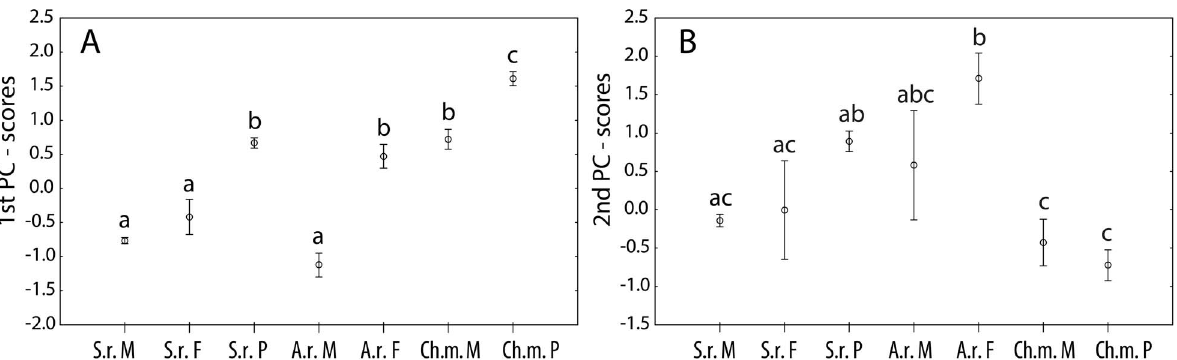
Fig. 3. Multivariate analysis of stoichiometric relations in three species of xylophagous beetles (PCA). ANOVA computed independently for the 1st and 2nd axis scores A – ANOVA for scores of the 1st principal component (F6, 76 5 91.919, p 5 0.0000); B – ANOVA for scores of the 2nd principal component (F6, 76 5 8.8204, p 5 0.00000); vertical bars denote standard errors. Values bearing different letters denote significant differences in the elemental composition between species, sexes and pupae (unequal N, HSD test, p , 0.05). S.r. M - Stictoleptura rubra males, S.r. F - Stictoleptura rubra females, S.r.